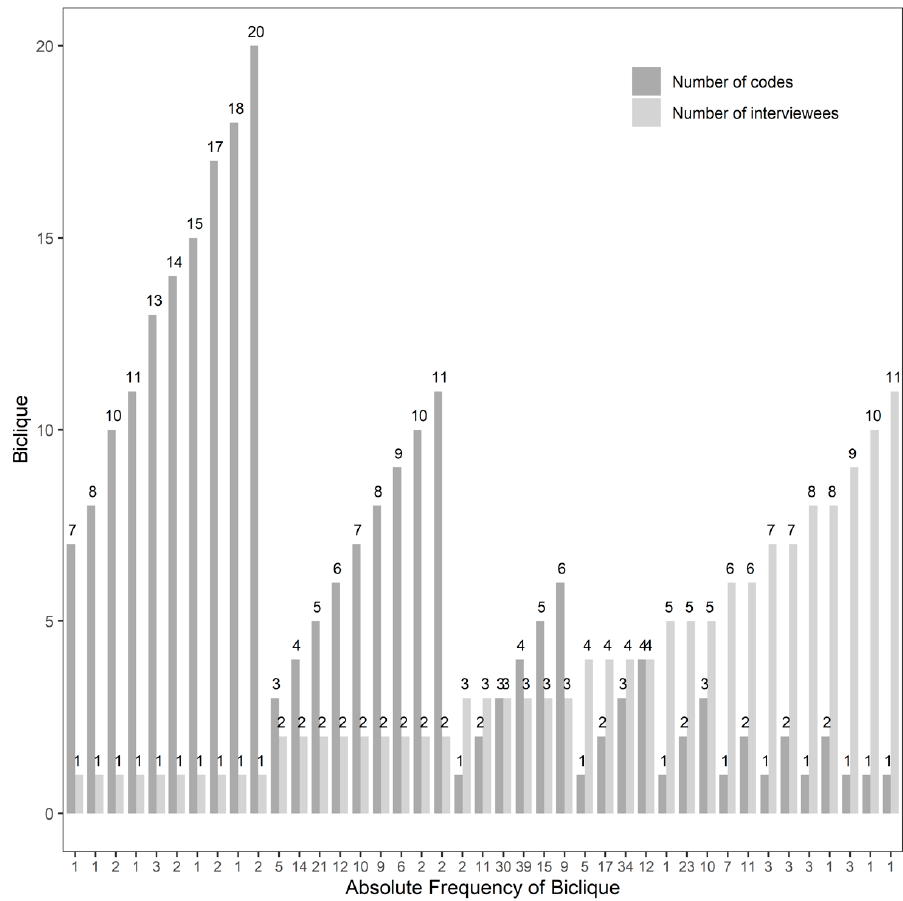
Figure 3. Overview on the identified bicliques, summarizing the number of codes having been addressed by a specific number of interviewees and their frequency.